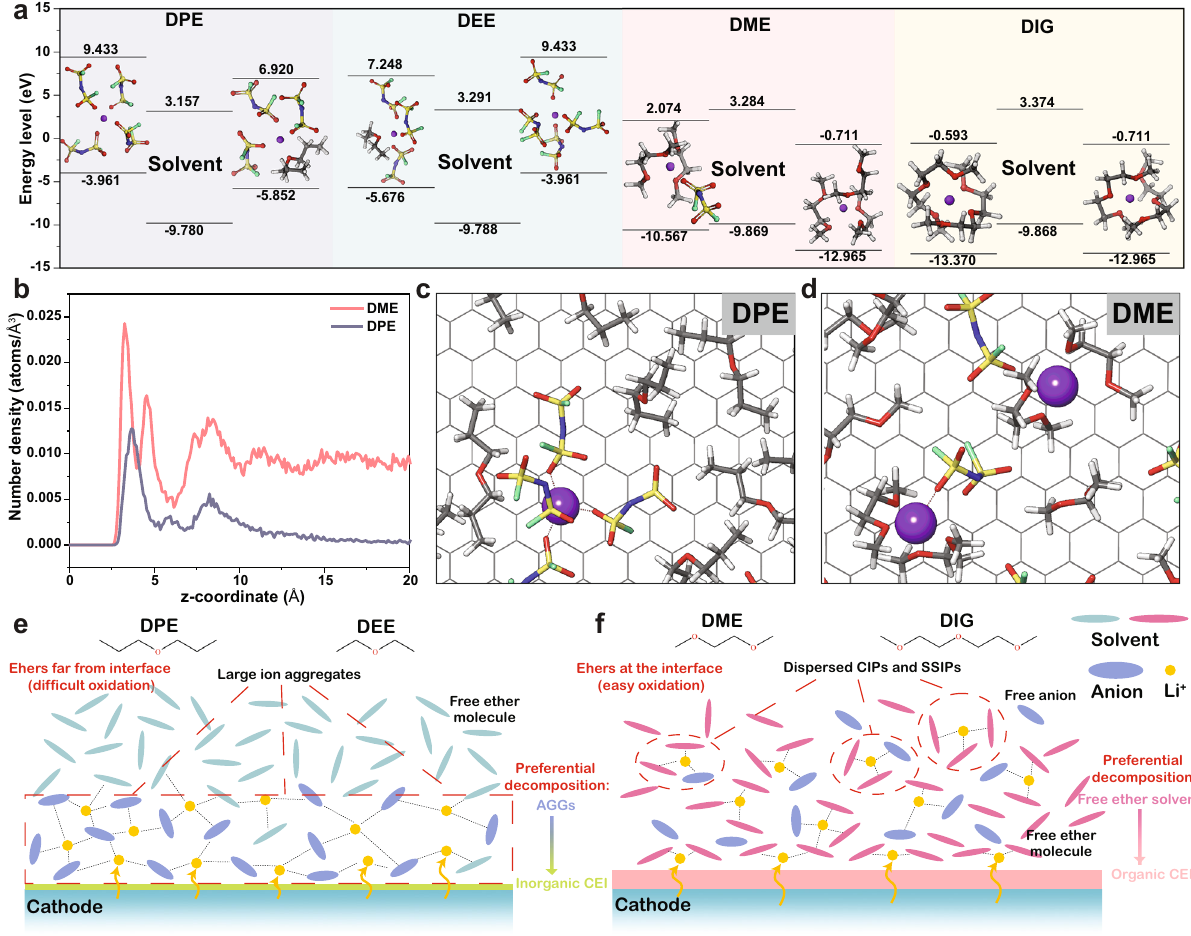
Fig. 4 | Theoretical study ofelectrolyte stability and the interfacial models. All the studied electrolytes contain 1.8M LiFSI as the salt. a Calculated LUMO-HOMO energy levels of solvent and top-two most probable solvation species in different electrolytes. b The number densities of ether solvent molecules in the inner